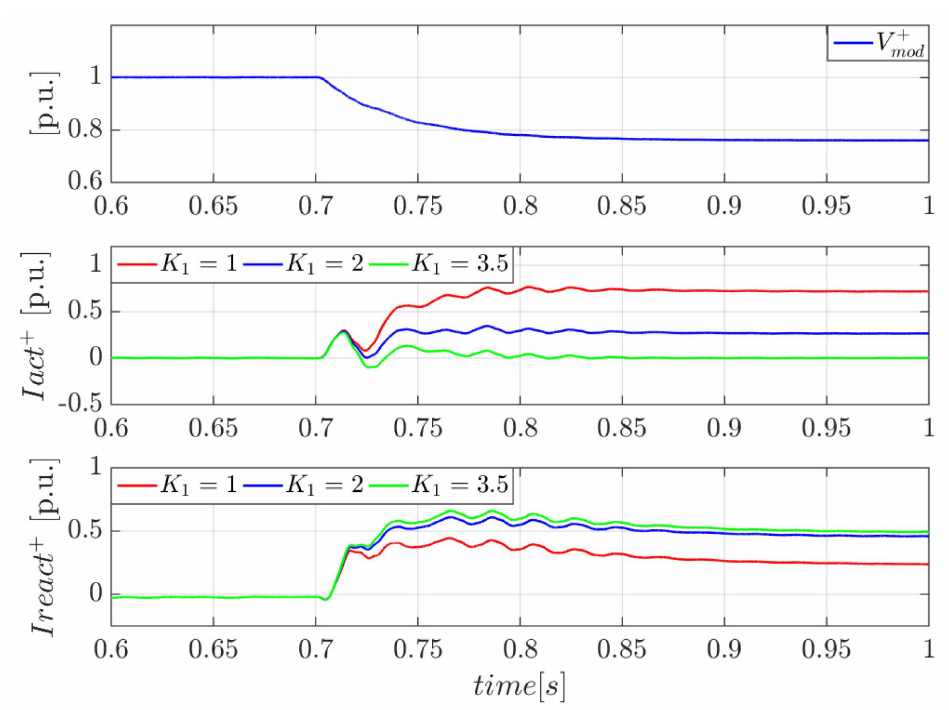
Figure 25. GFM converter positive sequence voltage and currents during the unbalanced fault for K and K different values. 2